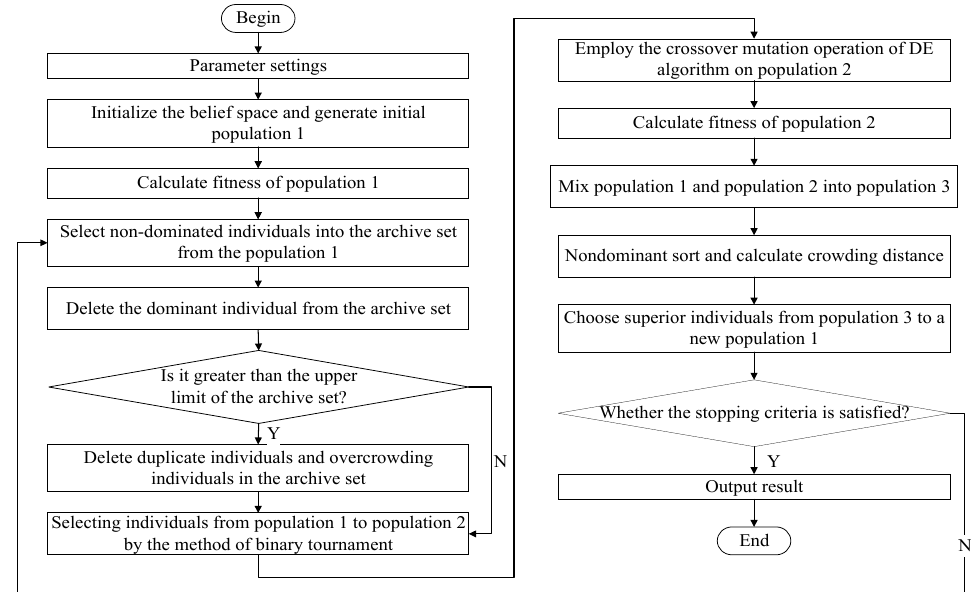
Figure 2. The flowchart of non-dominated sorting culture differential evolution (NSCDE).